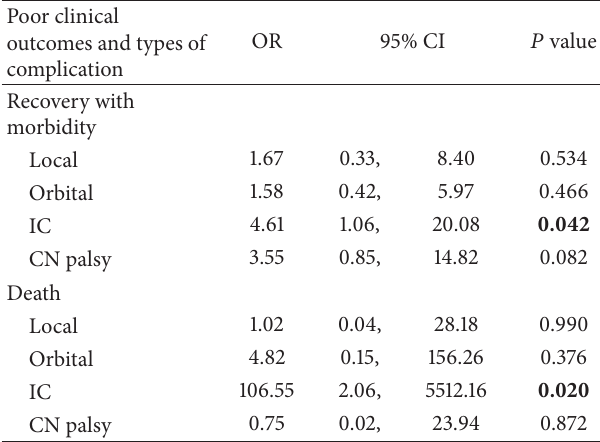
Table 3: Risk (odds ratio and 95% confidence interval) of poor clinical outcomes (recovery with morbidity or death) from the total number of complication types ∗ , analysed by multinomial logistic regression.